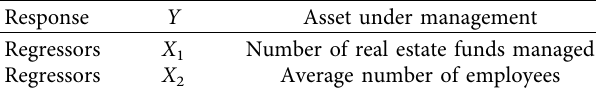
Table 2: First multivariate regression.